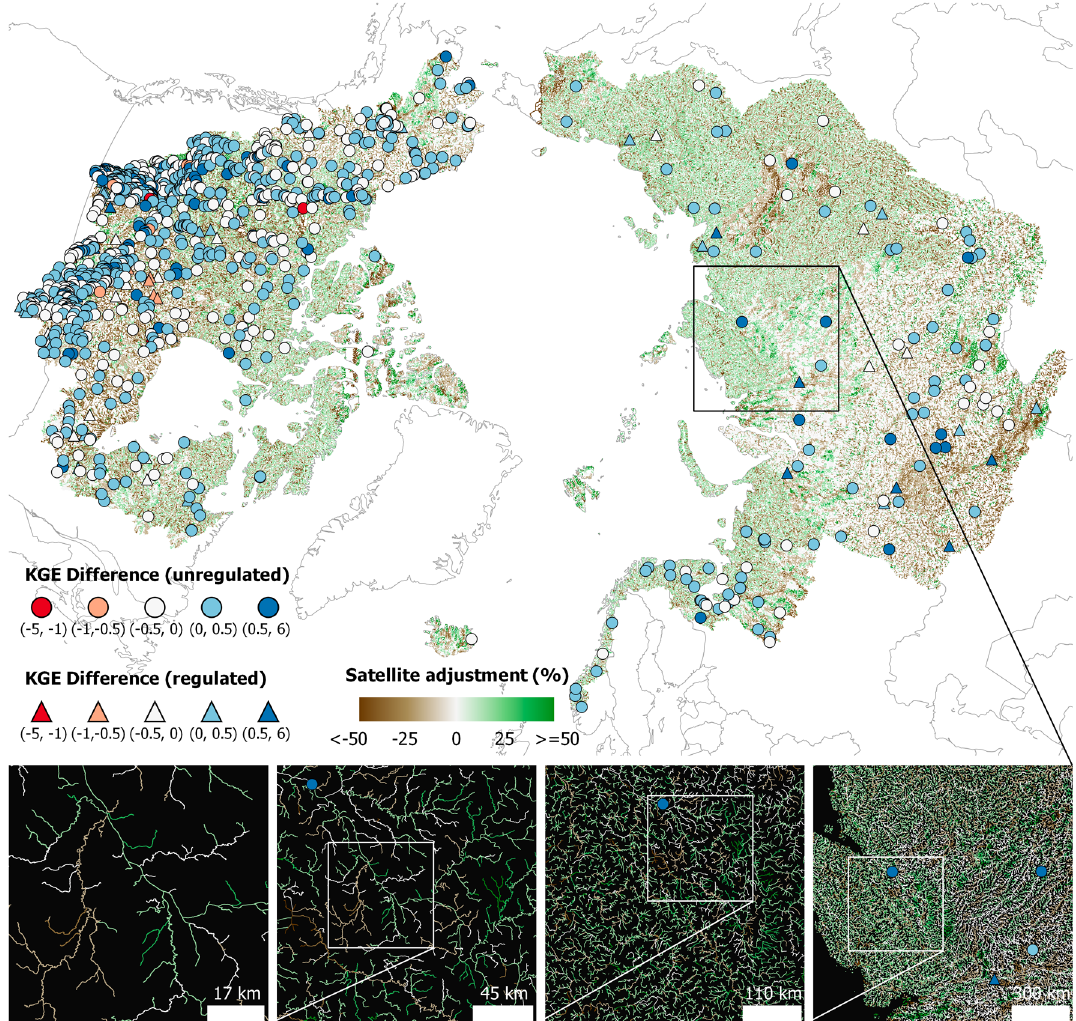
Fig. 3 Discharge differences attributed to satellite data. The satellite adjustment (relative difference, %) between RADR and baseline models in the annual mean discharge at each of 486,493 reaches is shown in a color gradient from brown (less water) to green (more water). Colored circles (for unregulated reaches) and triangles (for regulated reaches) indicate the difference in KGE (Kling-Gupta ef fi ciency, a standard error metric, positive difference indicates improvement) of daily discharge between RADR and baseline model simulations evaluated against 1,079 gauges at the daily scale. See Methods for the de fi nition of the regulated reach and baseline model simulations. The four boxes at the bottom show spatial details of the